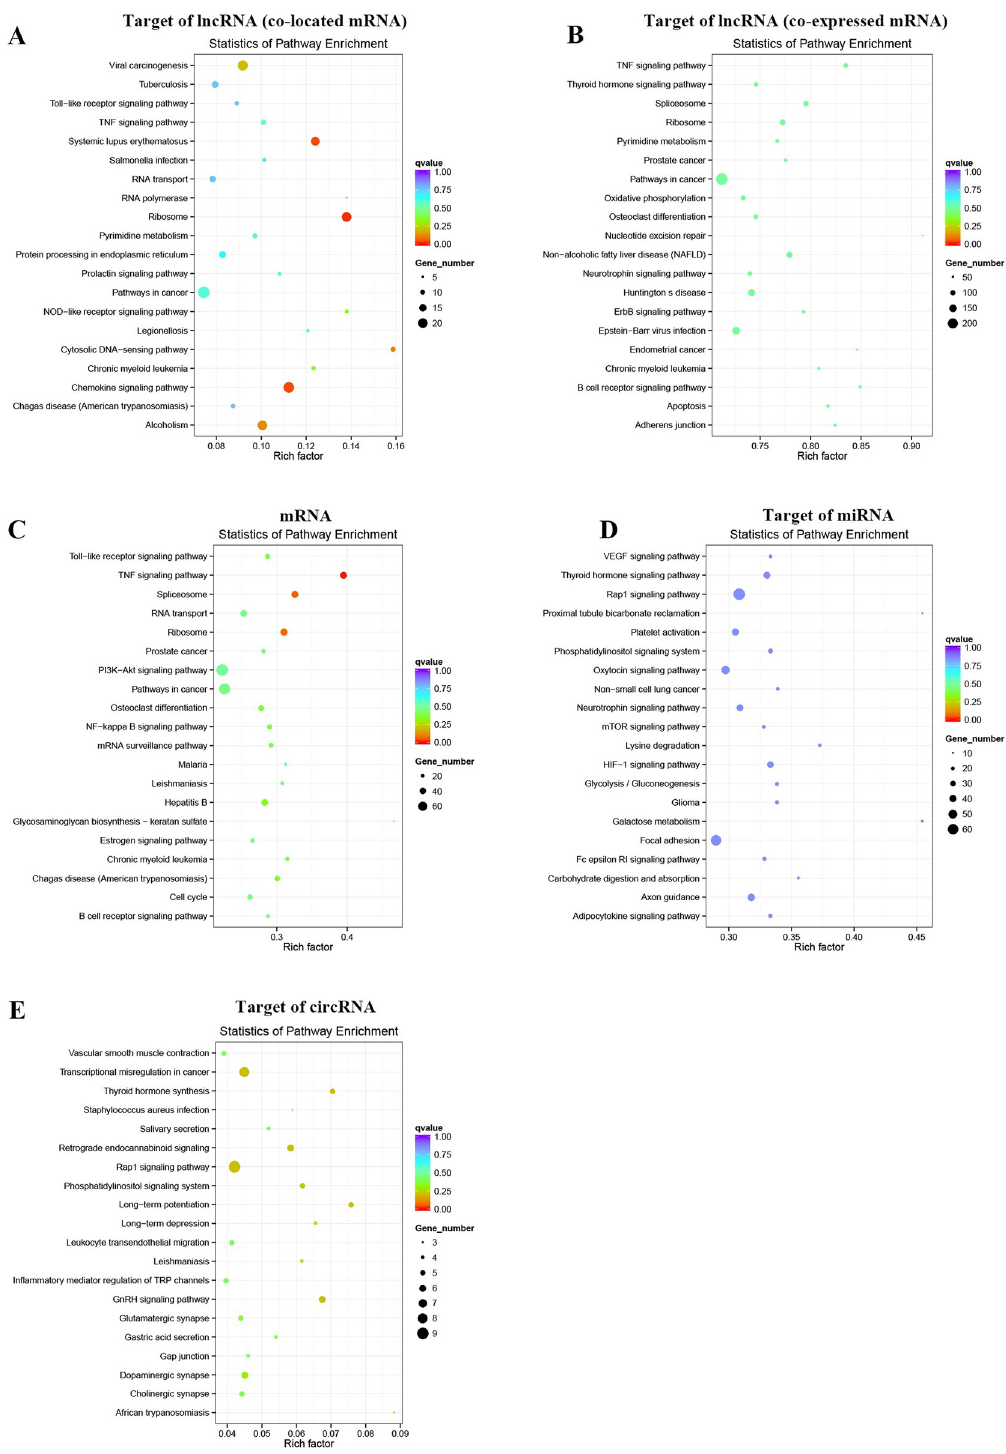
Fig 5. KEGG pathways enrichment. (A)-(E) The bubble plots of KEGG pathway enrichment for the target of lncRNAs, DE mRNAs, target of miRNAs, and target of circRNAs.